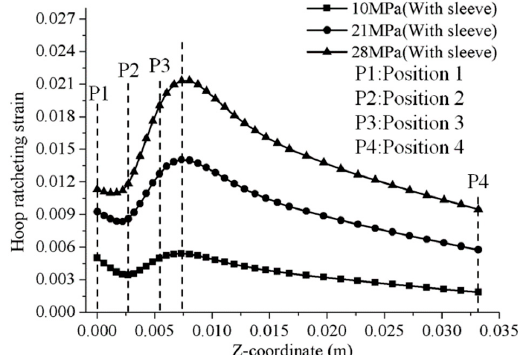
Figure 7. The ratcheting strain distribution between Position 1 and Position 4 under di ff erent internal pressures after 45